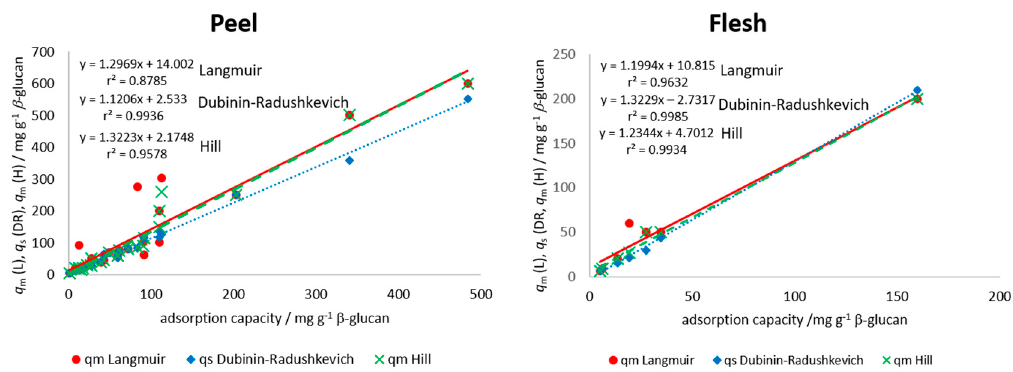
Figure 4. Correlation between adsorption parameters ( q m from Langmuir (L), q s from Dubinin–Radushkevich (DR), q m from Hill (H)), and experimental adsorption capacities ( q e ) for all individual polyphenols in the peel and in the flesh of apples (experimental adsorption capacities ( q e ) obtained in the experiment with the highest volume of polyphenol extract (300 µL) in reaction solution). Data from both types of apples are included in each correlation.